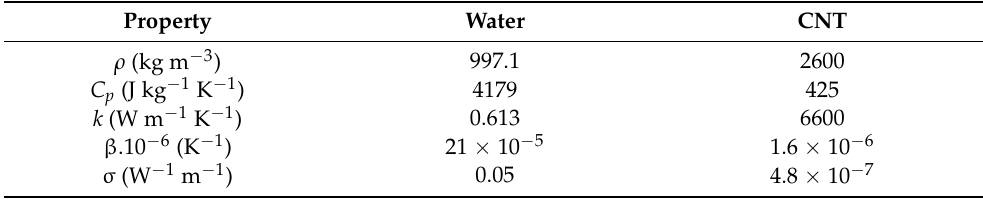
Figure 1. Schematic for the physical configuration studied. Table 1. Thermophysical properties of water and CNT-nanoparticles [23]. Reprinted with permission from ref. [23]. Copyright 2019